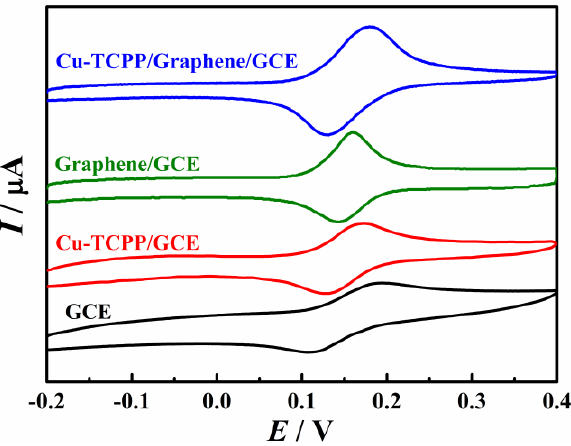
Figure 4. ( A – C ) CV curves of different materials with varied rates in 1 M KOH; ( D ) capacitive current at 0.20 V vs. scan rates.